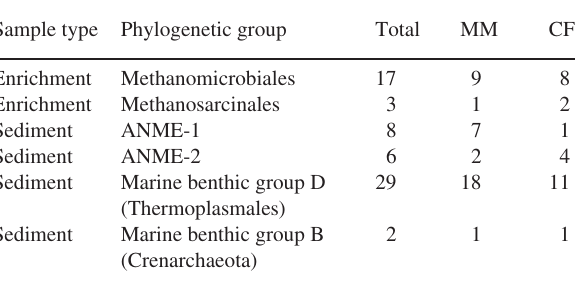
Table 2. Phylogeneticaffiliationof the enrichmentculturesand phylo- types obtained from Hydrate Ridge sediments. Abbreviations: MM = microbial mat site; and CF = clam field